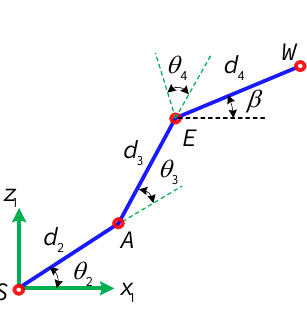
Figure 8. Geometric illustration of singular condition 3.